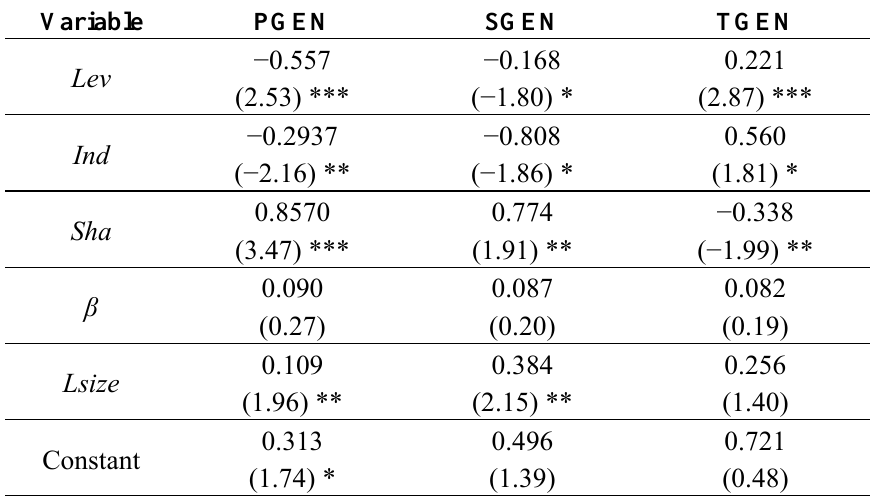
Table 7. Results of estimations based on generation family sample (first generation and second or more